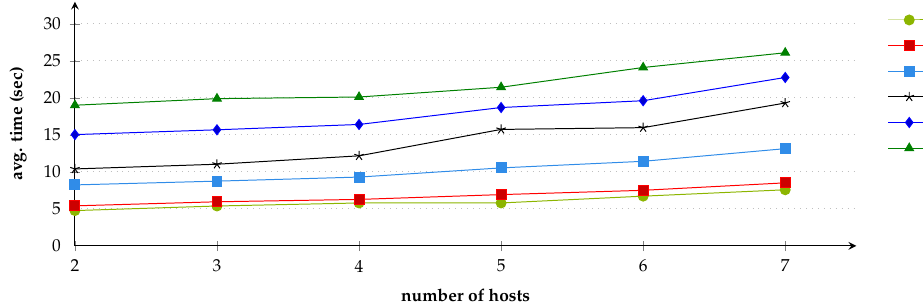
Figure 14. Query execution time in a federated setting for different time frames. Evaluation of linking to background knowledge stored on external servers is out of